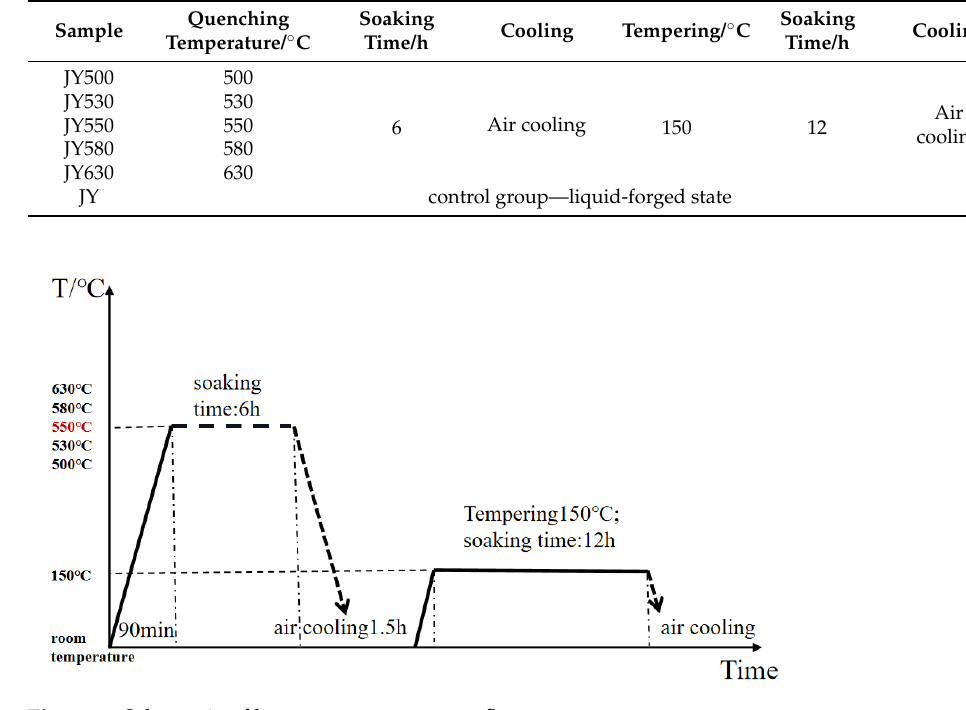
Figure 2. Schematic of heat treatment process flow.